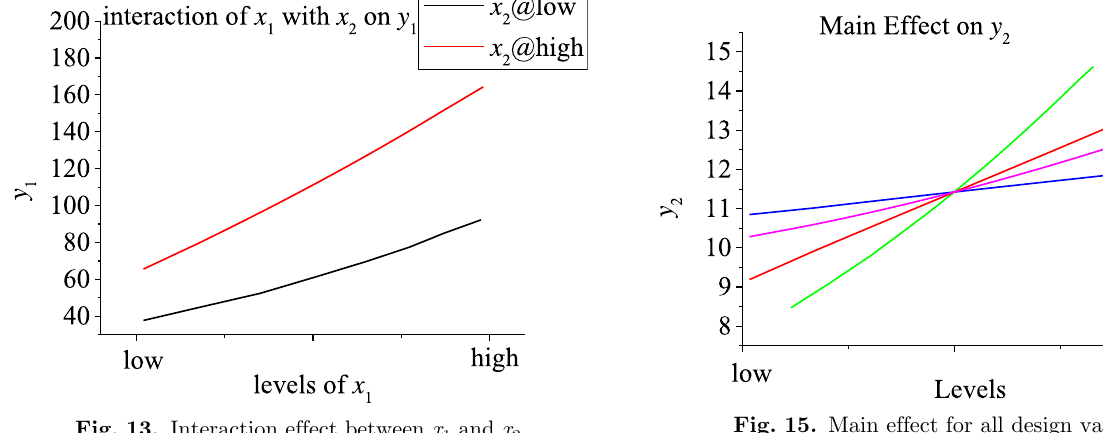
Fig. 13. Interaction effect between x 1 and x 2 .